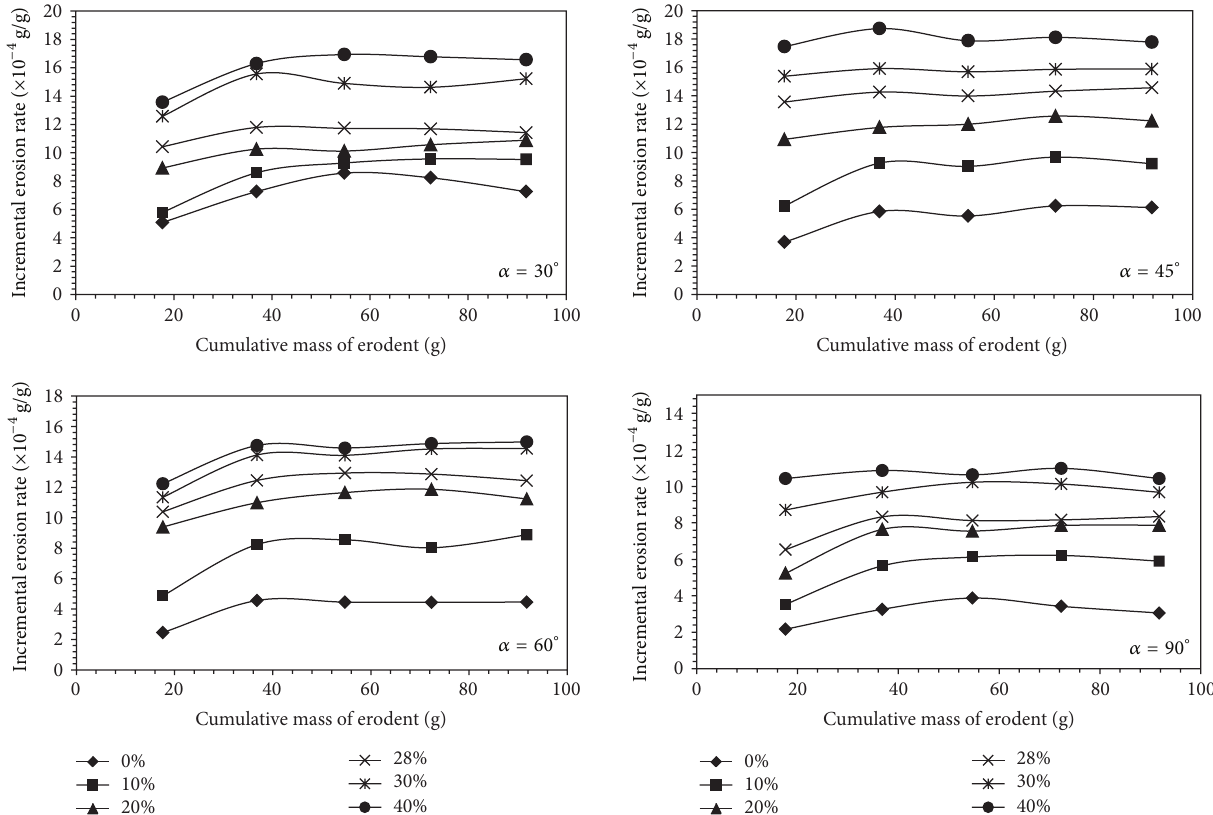
Figure 2: Variation of erosion rate of PVA/DPL composites as a function of cumulative weight of impinging particle at different impingement angles (15–90 ∘ ).